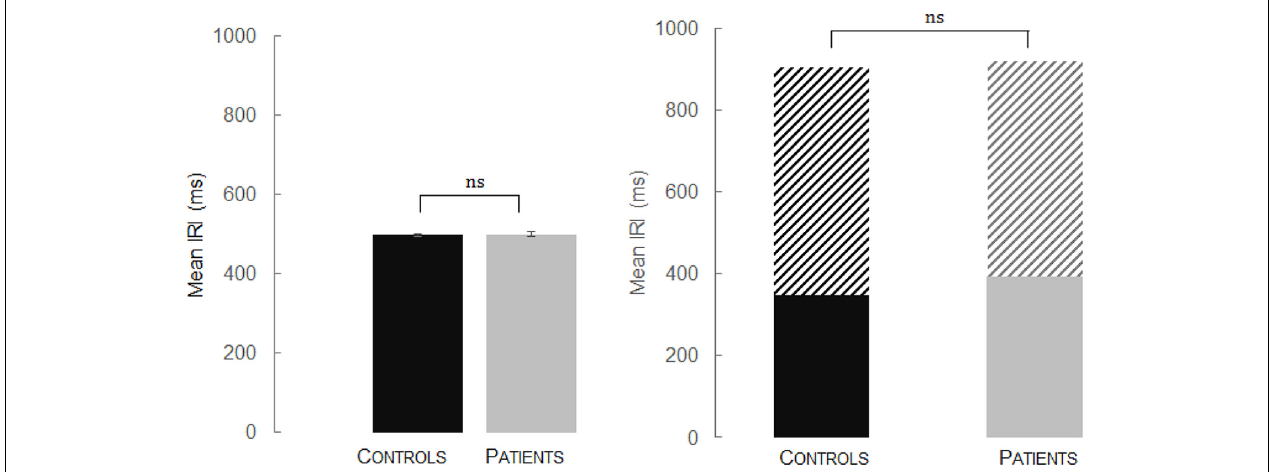
FIGURE 3 | Mean inter-response intervals (IRIs in ms – with their respective standard errors) in the equivalent isochronous rhythmic condition ( Left : R-eq) and in the alternating non-isochronous rhythmic condition ( Right : R-alt) as a function of the group (controls; patients). For the R-alt trials, the overall tempo combines results obtained for the long intervals (600 ms – coded with hatched lines) and for the short intervals (300 ms – coded with full color).